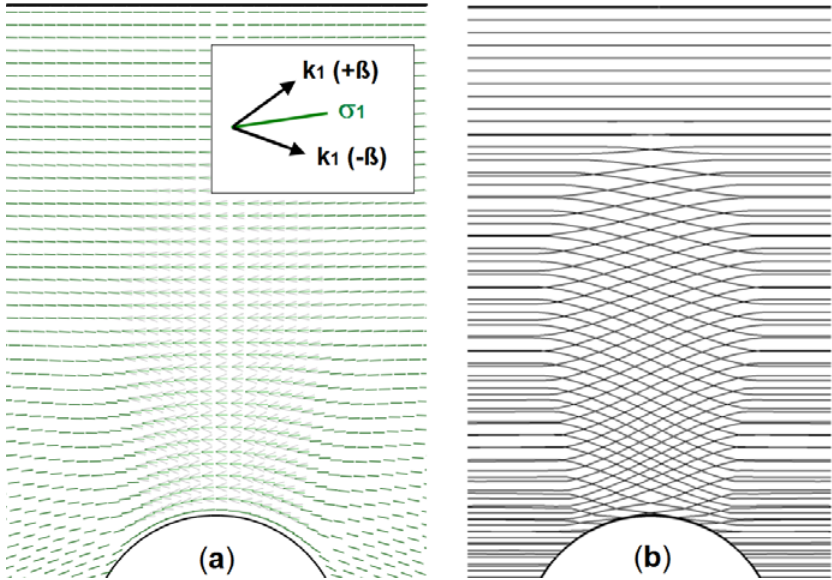
Figure 11. Perforated disc (detail) similar to Figure 7e. In areas with the same principal stress algebraic sign, the CBAP-laminate is optimal: ( a ) Correction angle ±ß regarding the σ 1 direction; ( b ) Integration of the modified direction field.